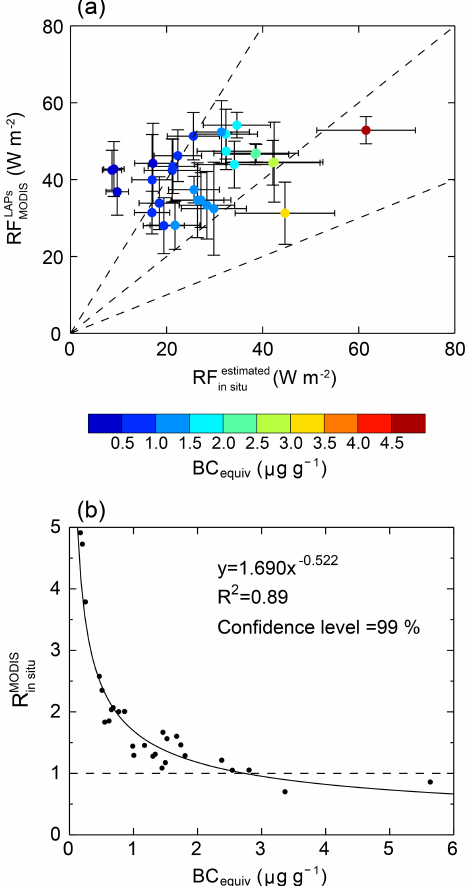
Figure 11. Scatterplots of (a) RF LAPs (b) R MODIS versus BC equiv insitu